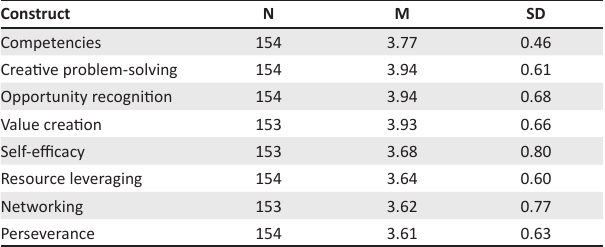
TABLE 1: The mean and standard deviation of each composite score for each competency.